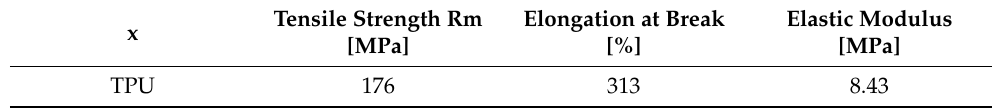
Table 1. The mechanical properties of pure